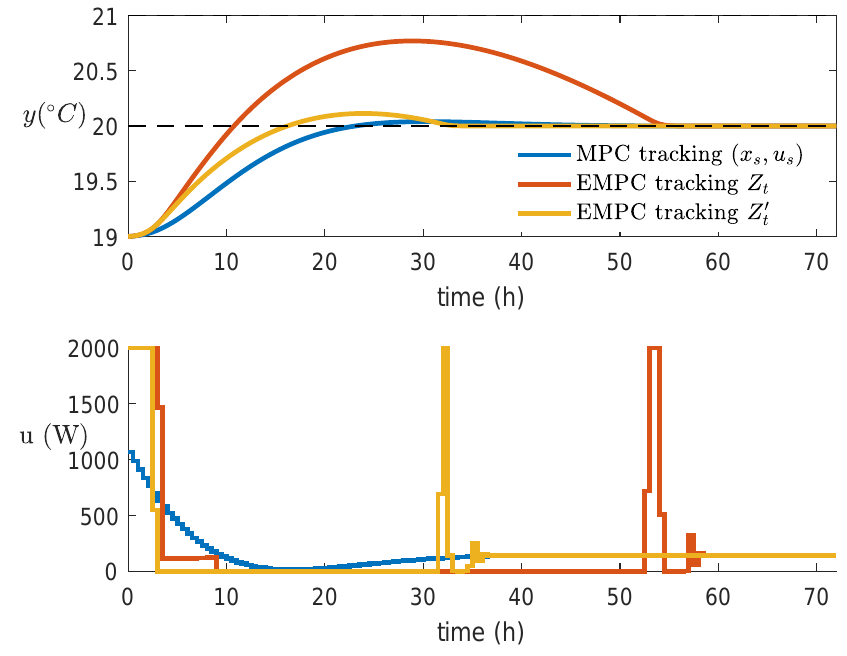
Figure 7. Room temperature and heat input profiles under different control schemes. Table 4. Additional electricity cost of the three control